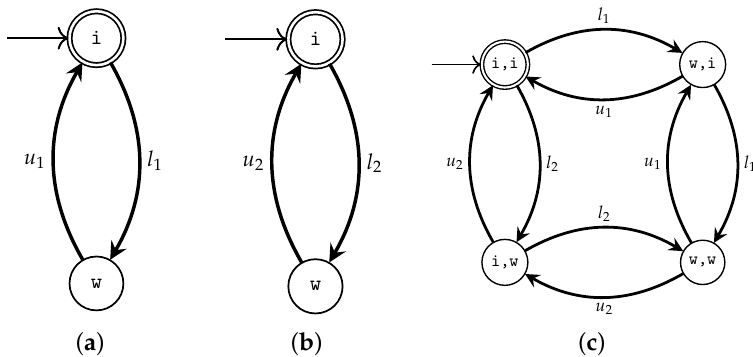
Figure 3. The example system. ( a ) R1; ( b ) R2; ( c ) joint behavior of R1 and